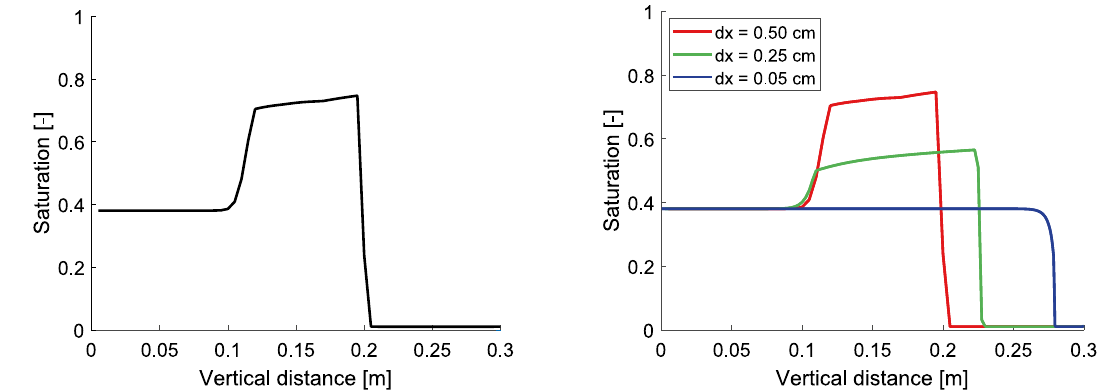
10 mins on time step (cid:31) t , the profiles are Figure 2. Left panel: The dependence of the moisture profile at t = almost identical for a range of (cid:31) t between 10 − 3 and 10 − 5 . Right panel: The dependence of the moisture profile at 10 minutes on (cid:31) x . As (cid:31) x 0 , without proper scaling of the retention curve, the overshoot behavior would t = → disappear. The parameters used for the simulations are given in Table